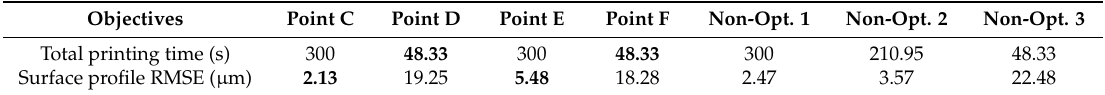
Table 10. Objectives comparison between optimized and non-optimized printing